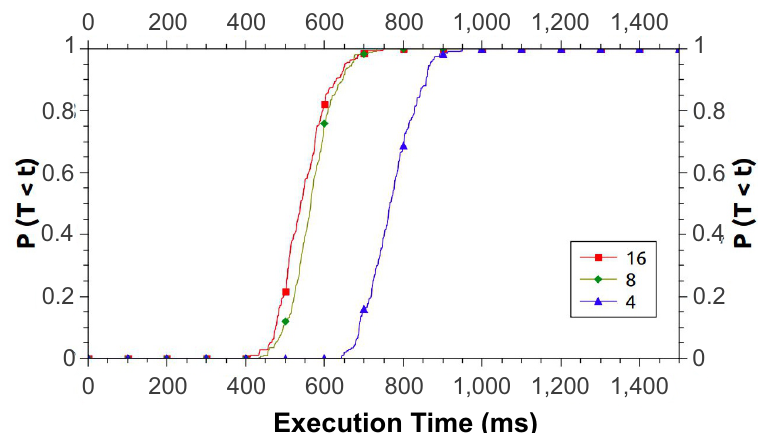
Figure 9. Cumulative Distribution Functions for Study